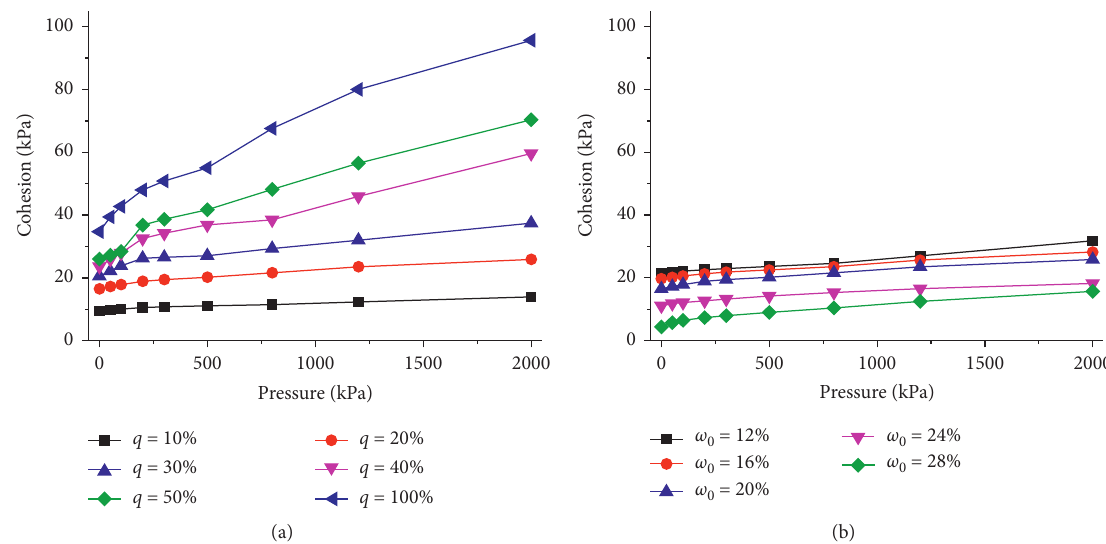
Figure 11: Relationship between cohesion of sand and grouting pressure. (a) At different clay contents. (b) At different initial water ratios.